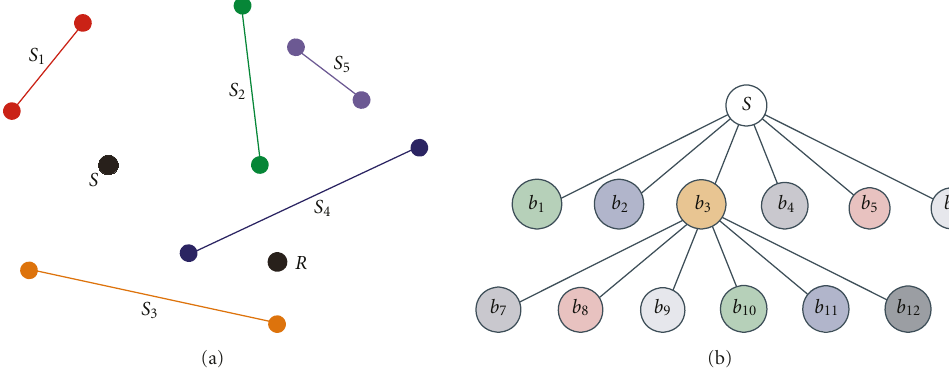
Figure 5: Path-tracing from source S to the receiver R . The beam-tree on the right-hand side is the same as in Figure 3.